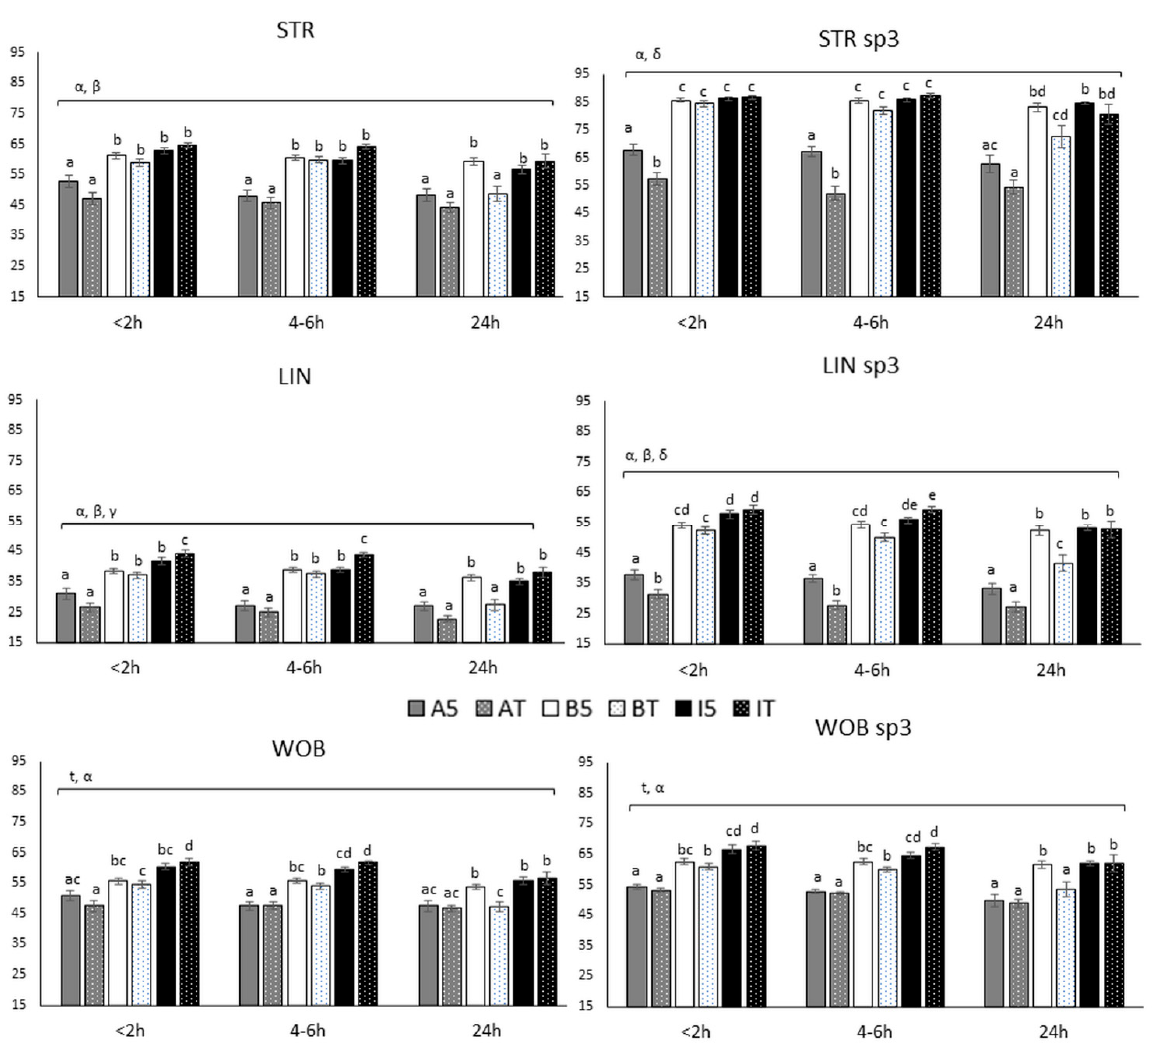
Figure 5. Ratios STR, LIN and WOB of all subpopulations and specifically sp3, at three different time-windows until assessment (<2, 4–6 and 24 h), with three different extenders (AndroMed ® , BIOXcell ® and INRA96 ® ) and at two holding temperatures (refrigeration vs. room temperature). Bars with different letters mean statistical significantly different values ( p < 0.05) among the six combinations extender by holding temperature, at each time window (ANOVA analyses). Square brackets over the bars highlight statistically significant effects ( p < 0.05; from GLM analyses) of the factors or factors’ interactions (Greek letters), during the time-windows embraced. Abbreviations: CASA: Computer Assisted Semen Analyses; STR: straightness (VSL/VAP); LIN: linearity (VSL/VCL); WOB: wobble (VAP/VCL); sp3: fast subpopulation. A: AndroMed ® ; B: BIOXcell ® ; I: INRA96 ® ; T: room temperature; 5: refrigeration at 5 ◦ C. < 2h: time of assessment <2 h after collection; 4–6 h: time of assessment 4–6 h after collection; 24 h: time of assessment 24 h after collection; α : interaction temperature by extender; β : interaction temperature by time; γ : interaction extender by time; δ : interaction temperature by extender by